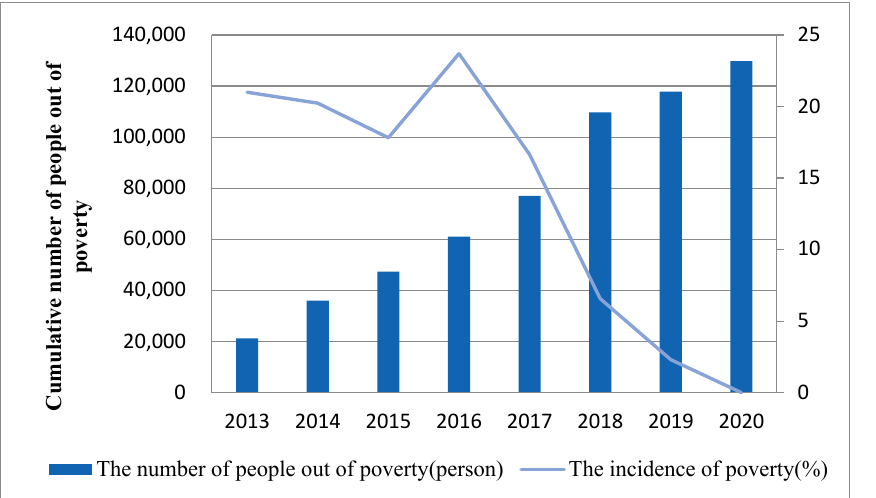
Figure 8. The incidence of poverty and cumulative number of people out of poverty in Yushu Prefecture from 2013 to 2020.